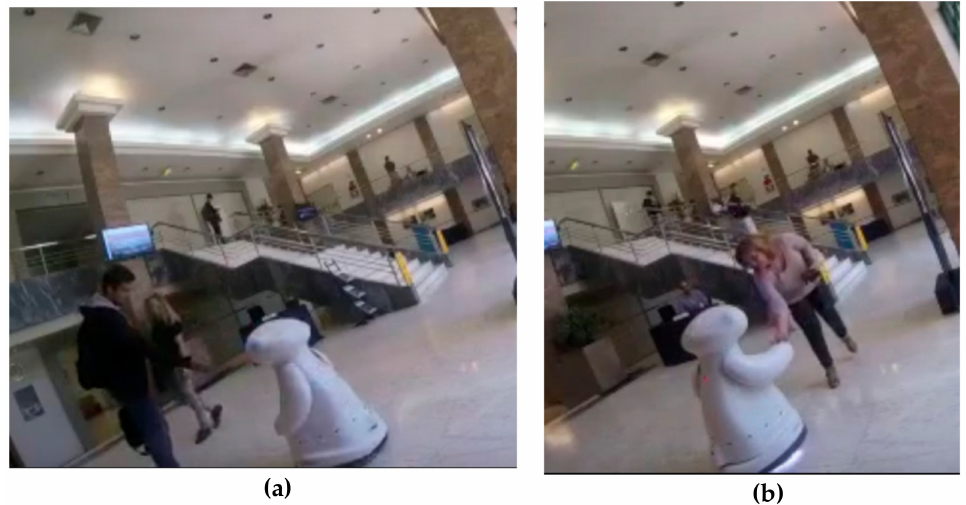
Figure 3. ( a ) Person trying to initiate an interaction without success (not getting a proper response from the robot); ( b ) Person initiating a successful interaction (getting a proper response from the robot).